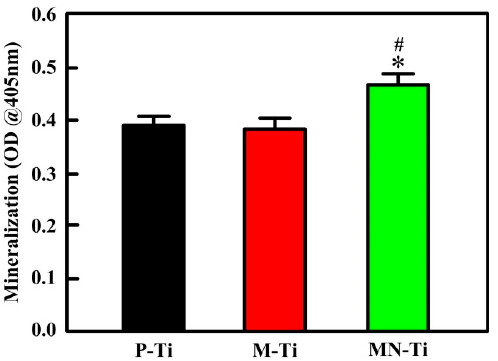
Figure 12. Mineralization of MC3T3 cells grown on different sample surfaces for 21 days. # p < 0.05 compared with the M-Ti sample. * p < 0.05 compared with the P-Ti sample.